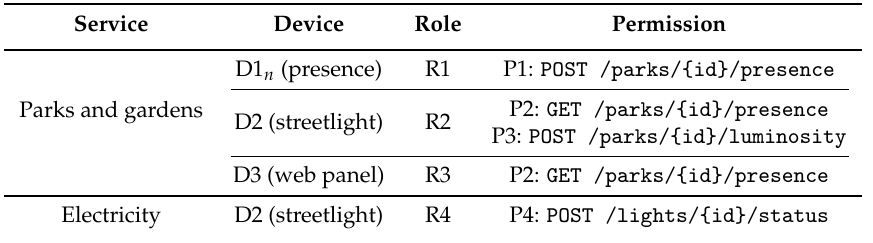
Table 2. Devices’